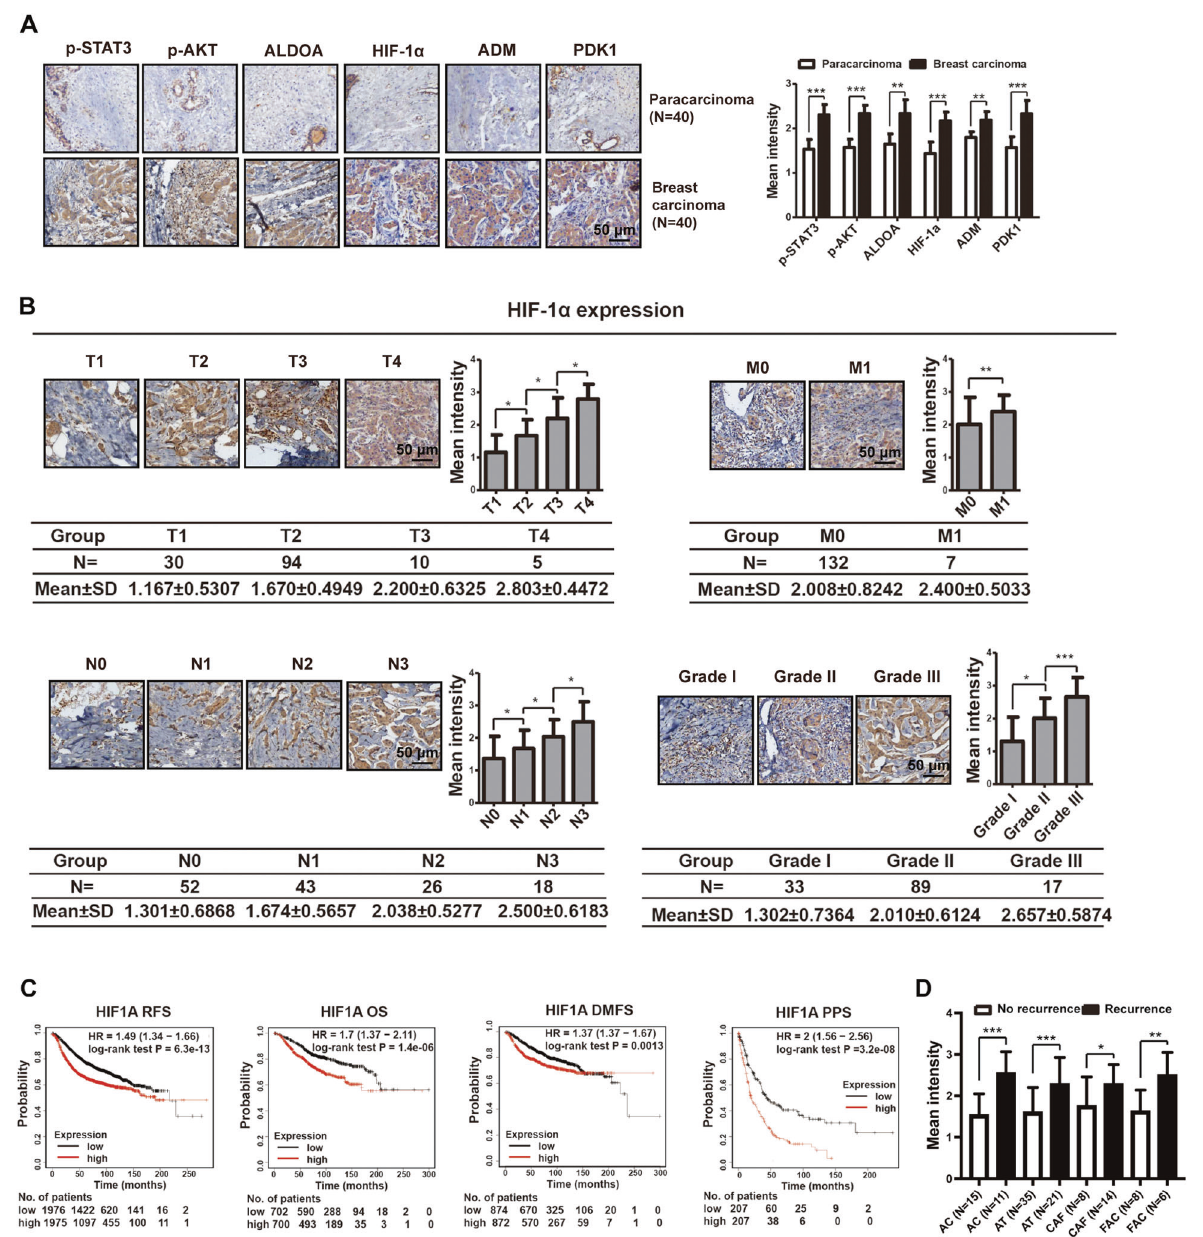
Fig. 7 ATP-HIF-1 α signaling is associated with clinical breast cancer progression. A IHC staining demonstrated high expressions of molecules involved in ATP-HIF-1 α signaling in breast cancer tissues compared with paired paracarcinoma tissues. B IHC illustrated that HIF-1 α level was associated with breast cancer TNM stage and grade. Data were calculated by Image Pro-Plus (IPP) (Media Cybernetics, Inc., Rockville, MD, USA). C Kaplan – Meier survival analysis (http://kmplot.com/analysis/) showed the negative correlations between survival time of breast cancer patients and expressions of HIF-1 α . RFS relapse-free survival; OS overall survival; DMFS distant metastasis-free survival; PPS post- progression survival. D IHC showed that high expressions of HIF-1 α is associated with recurrence after chemotherapy combination treatment. AC = Adriamycin + Cyclophosphamide, AT = Adriamycin + Taxotere, CAF = Cyclophosphamide + Adriamycin + Fluorouracil, FAC = Fluorour- acil + Adriamycin + Cyclophosphamide. Error bars represent means ± SD from at least triplicates. Data are representative of at least